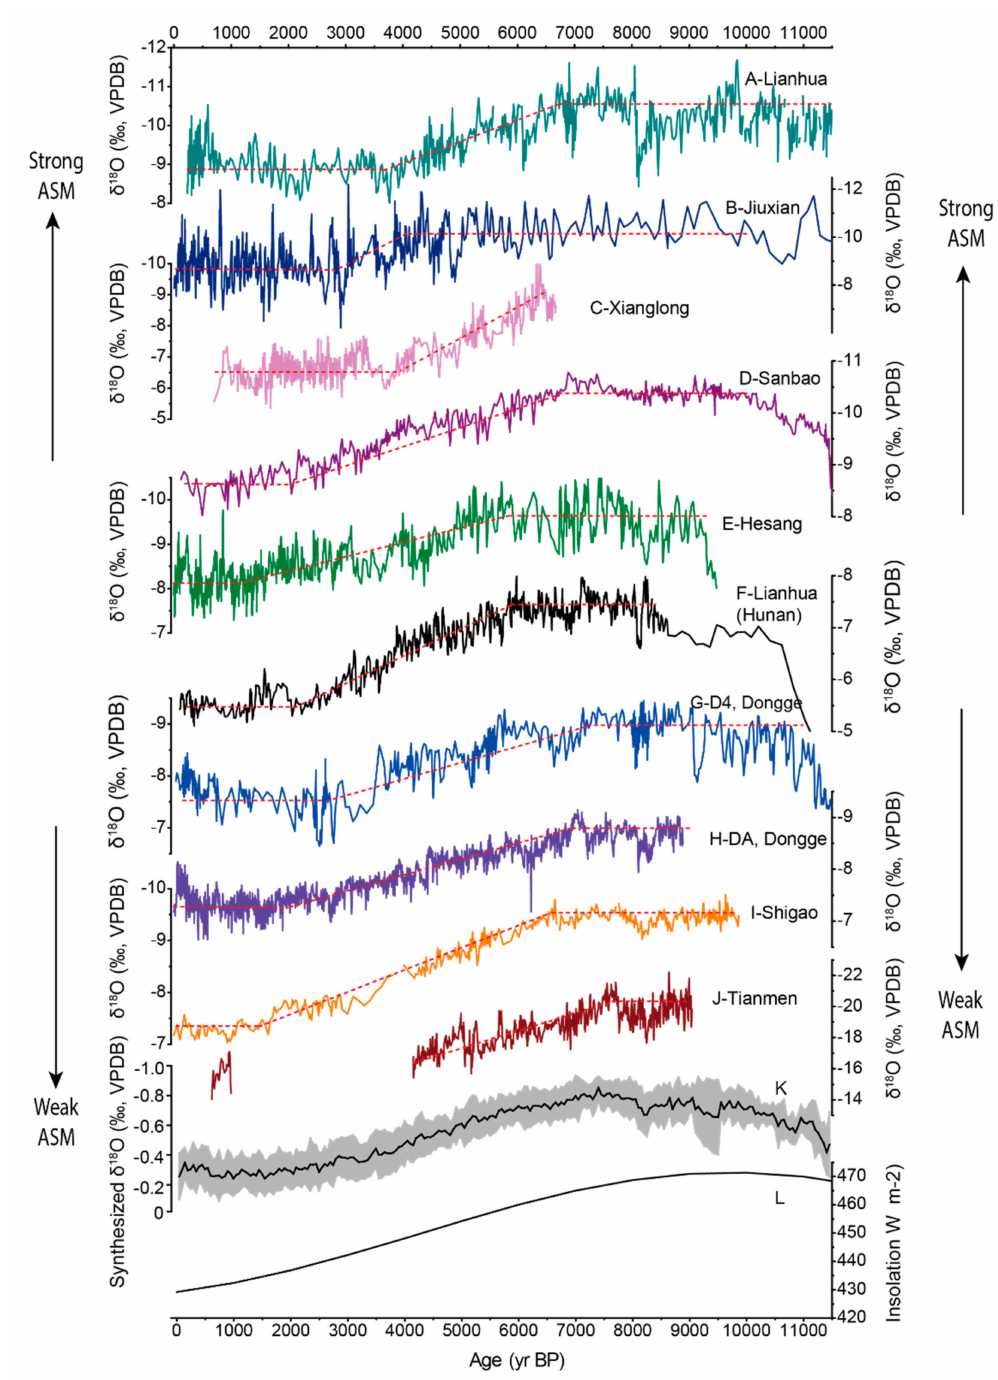
Figure 7. Holocene stalagmite δ 18 O records from China. ( A ) Composite record from Lianhua Cave (Shanxi) [74]; ( B ) Composite record (C996-1 and C996-2) from Jiuxian Cave [75]; ( C ) Composite record (XL2, XL16 and XL26) from Xianglong Cave [151]; ( D ) Composite record (SB27 and SB43) from Sanbao Cave [113]; ( E ) HS4 record from Heshang Cave [15]; ( F ) LH2 record from Lianhua Cave [81]; ( G ) D4 record from Dongge Cave [45]; ( H ) DA record from Dongge Cave [8]; ( I ) Composite record (SG1 and SG2) from Shigao Cave [125]; ( J ) Composite record (TM18a and TM18b) from Tianmen Cave [25]; ( K ) Synthesized speleothem δ 18 O record calculated averaging 16 records in the monsoonal China [224], gray shadow indicates standard deviations; ( L ) 21 July insolation at 65 ◦ N [206]. The red, dashed lines in ( A – J ) show the best fit using the RAMPFIT program